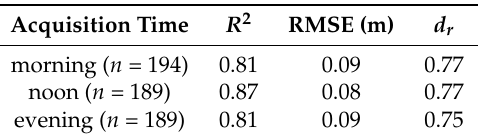
Table 2. Statistics for the linear regression of CSM-derived and manual height per plot for the three acquisition times of the selected CSMs. R 2 : coefficient of determination; RMSE: root mean square error;